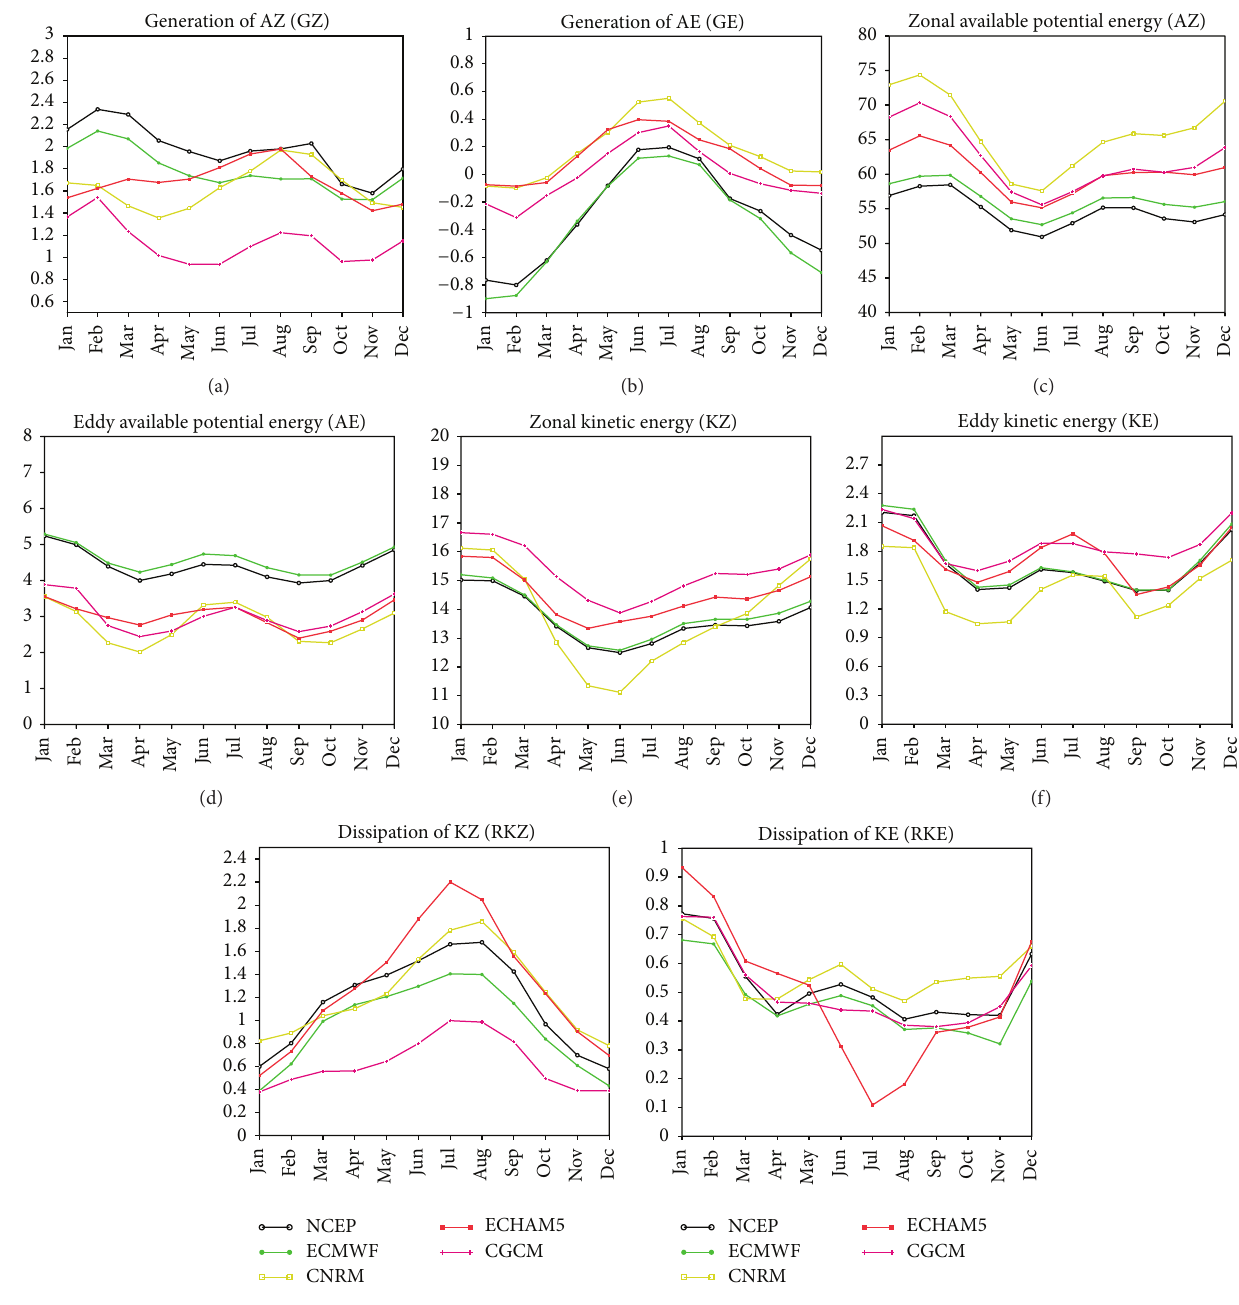
Figure 1: Climatological annual cycle of the generation of zonal available potential energy (a), generation of eddy available potential energy (b), zonal available potential energy (c), eddy available potential energy (d), zonal kinetic energy (e), eddy kinetic energy (f), dissipation of KZ (g), and dissipation of KE (h) for the period from 1979 to 1999. Standard units are 10 5 Jm −2 for energy terms and Wm −2 for generation and dissipation